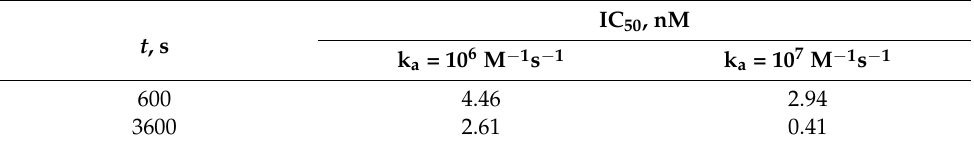
Table 4. IC 50 values of theoretical calibration curves of non-equilibrium competitive assay for varied durations of immune interaction (t) and varied kinetic association constants (ka). The concentration of antigen derivative [ Ag *] 0 was 0.16 nM, the concentration of specific antibodies [ Ab ] 0 was 0.2 nM, all kinetic dissociation constants k d were 0.0001 1/s, and the association constant with modified antigen k a2 was 10 7 M − 1 s − 1 .